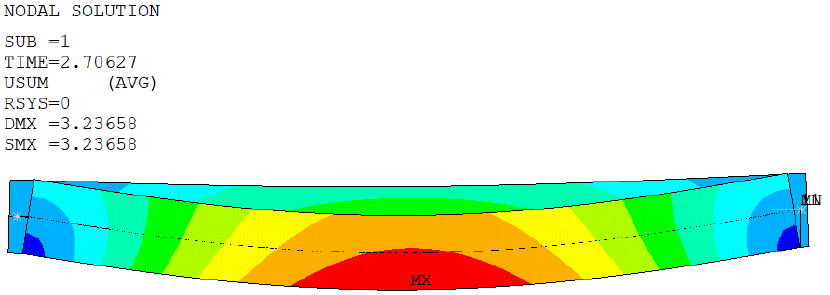
Figure 19. The deformation of the beam-column without warping restraints at failure (scale factor = 12).